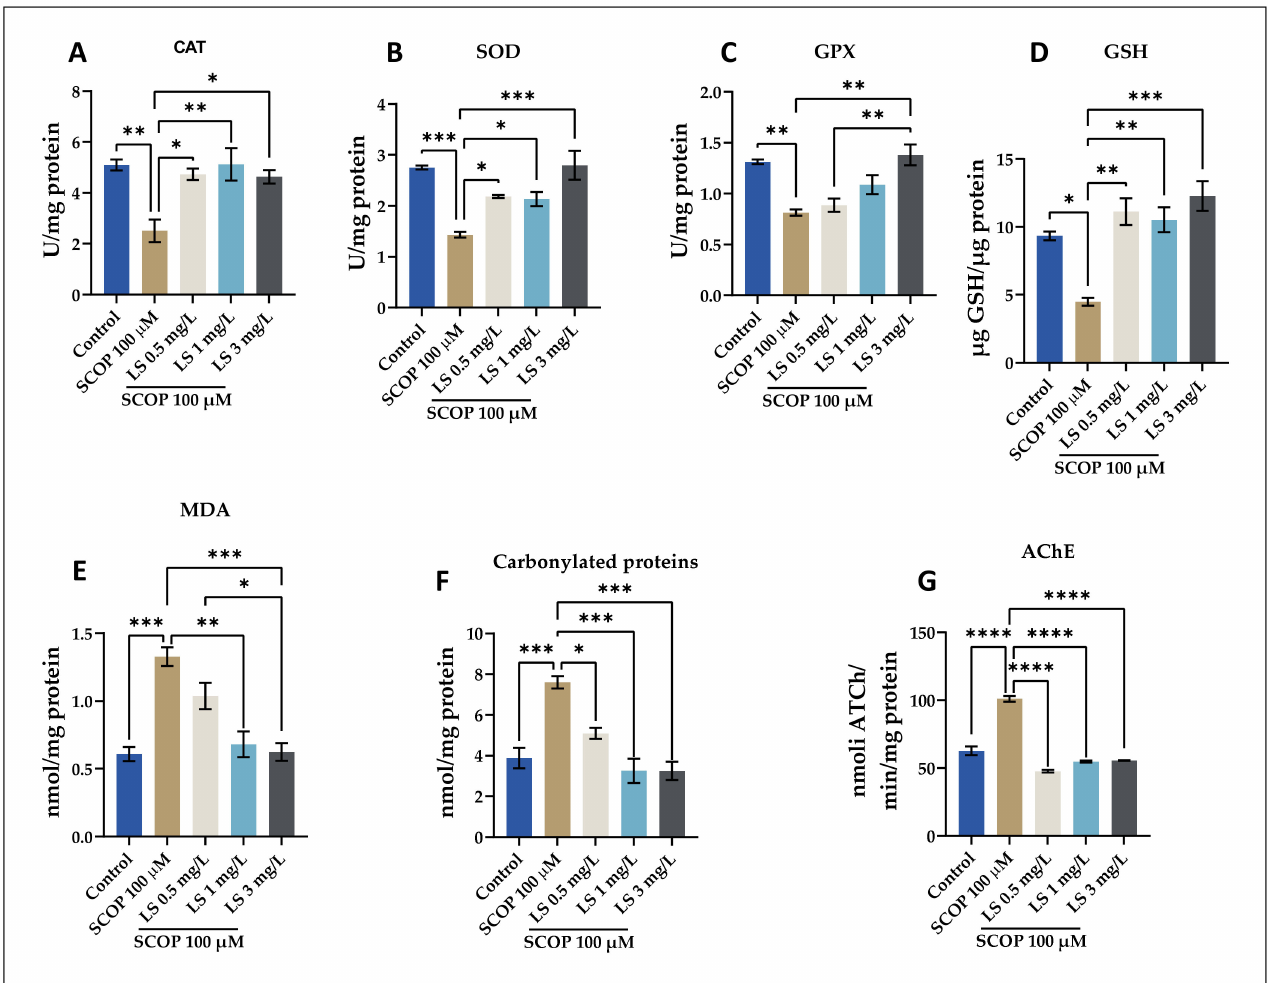
Figure 7. Lycopodium selago hydroethanolic extract (LS: 0.5, 1, and 3 mg/L) exhibited an anti-AChE effect and improved the antioxidant status in the zebrafish brain. ( A – D ) Representation of the enzymes specific activity (CAT, SOD, GPX and GSH) in different groups; ( E , F ) Representation of the MDA and protein carbonyl levels in different groups; ( G ) AChE-specific activity. Values are means ± S.E.M. ( n = 10). For Tukey’s post-hoc analyses: **** p < 0.0001, *** p < 0.001, ** p < 0.01, and * p <